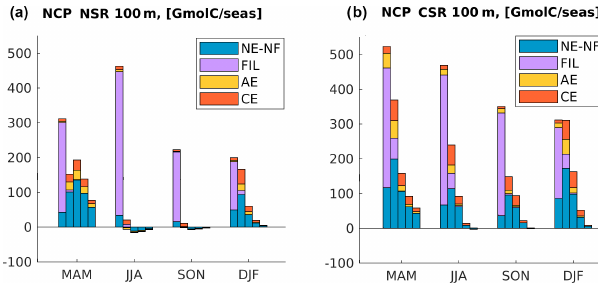
Figure 8. Divergence of the offshore flux of C org integrated in the first 100m of depth in (a) northern and (b) central CanUS. Each group of bars represents a different season. For each season, each one of the five bars represents the difference between the input and the output of offshore flux within two specific offshore boundaries (divergence), i.e., isolines of distance from the coast. From left to right in each group: 0 to 100km offshore, 100 to 500km offshore, 500 to 1000km offshore, 1000 to 1500km offshore, and 1500 to 2000km offshore. Colors in each bar represent the contribution by a certain type of structure: non-eddy–non-filament (NE–NF), fila- ments (FIL), anticyclones (AEs), and cyclones (CEs). Positive and negative contributions to the flux through each boundary are plotted separately in order to make them clearly